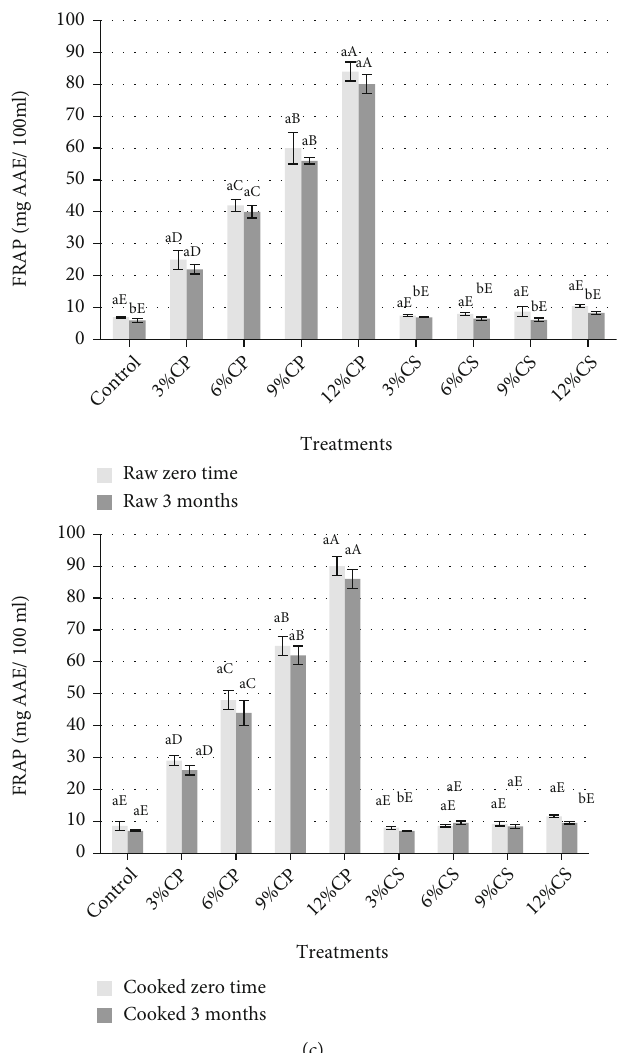
Figure 4: Changes in (a) total phenolic (TP), (b) DPPH scavenging activity, and (c) FRAP values of raw and cooked chicken patties supplemented with cantaloupe peel (CP) and seeds (CS) powder during storage at -20 for 3